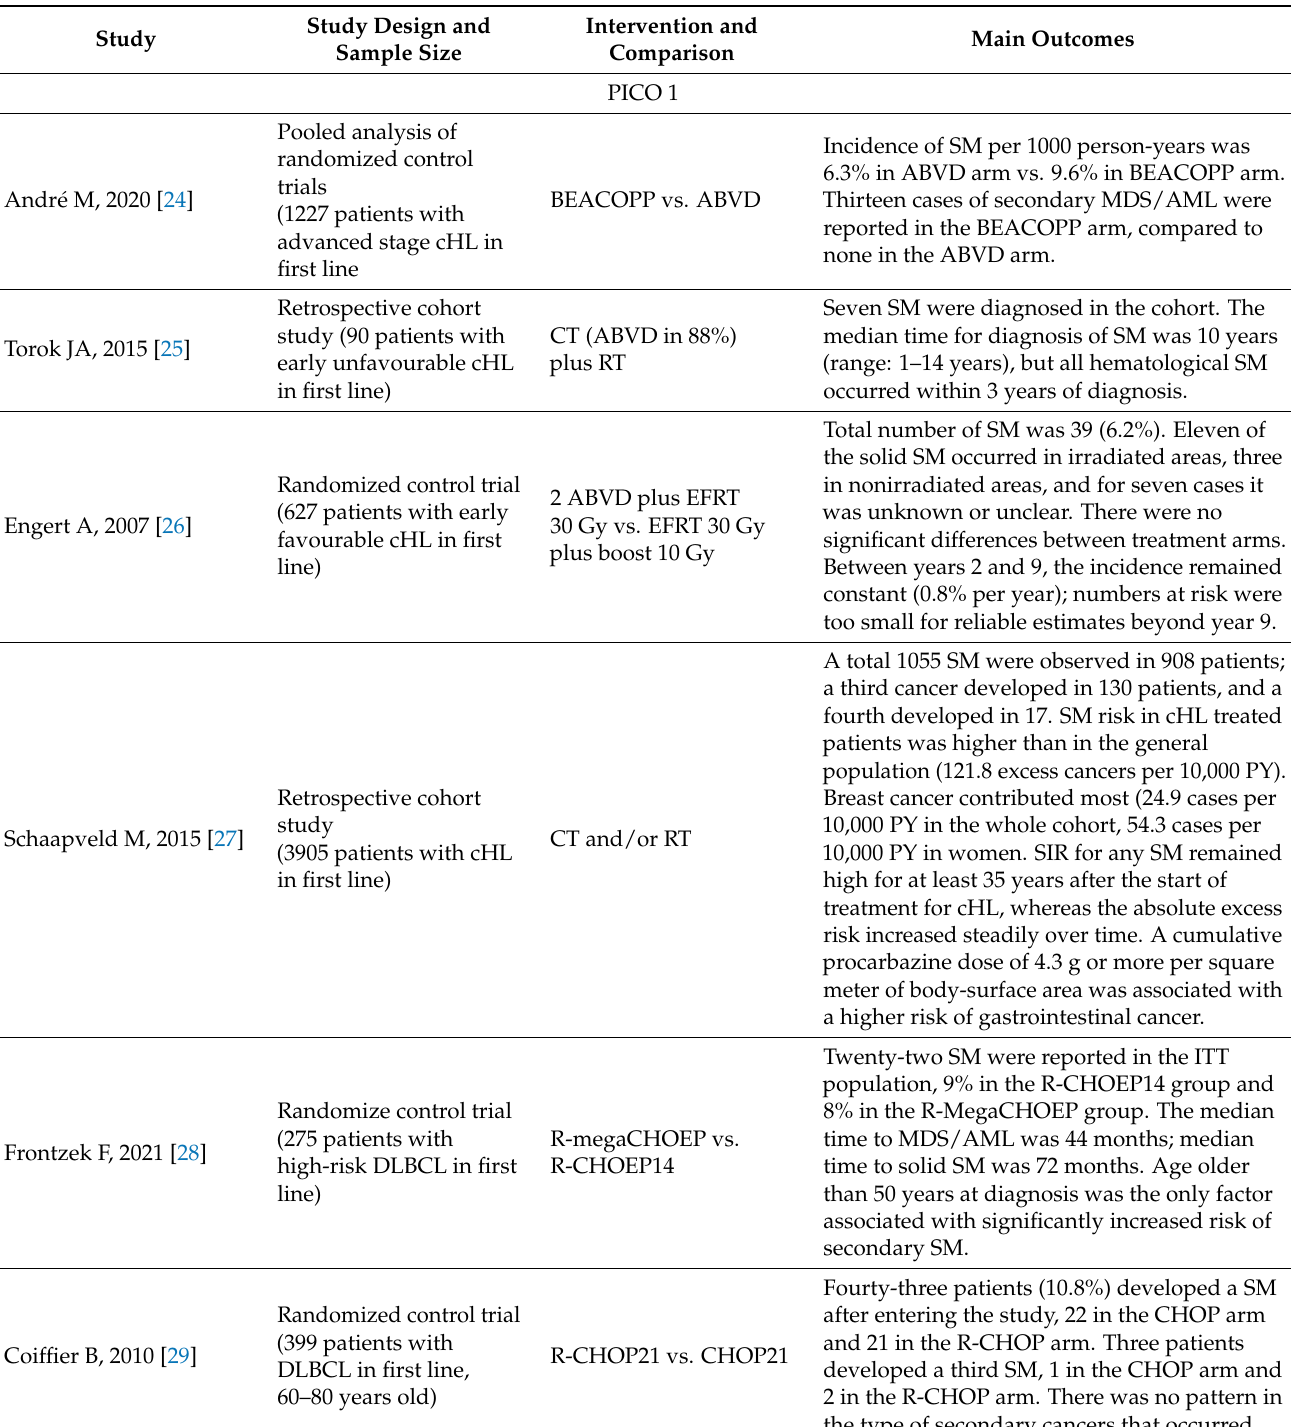
Table 2. Summary of